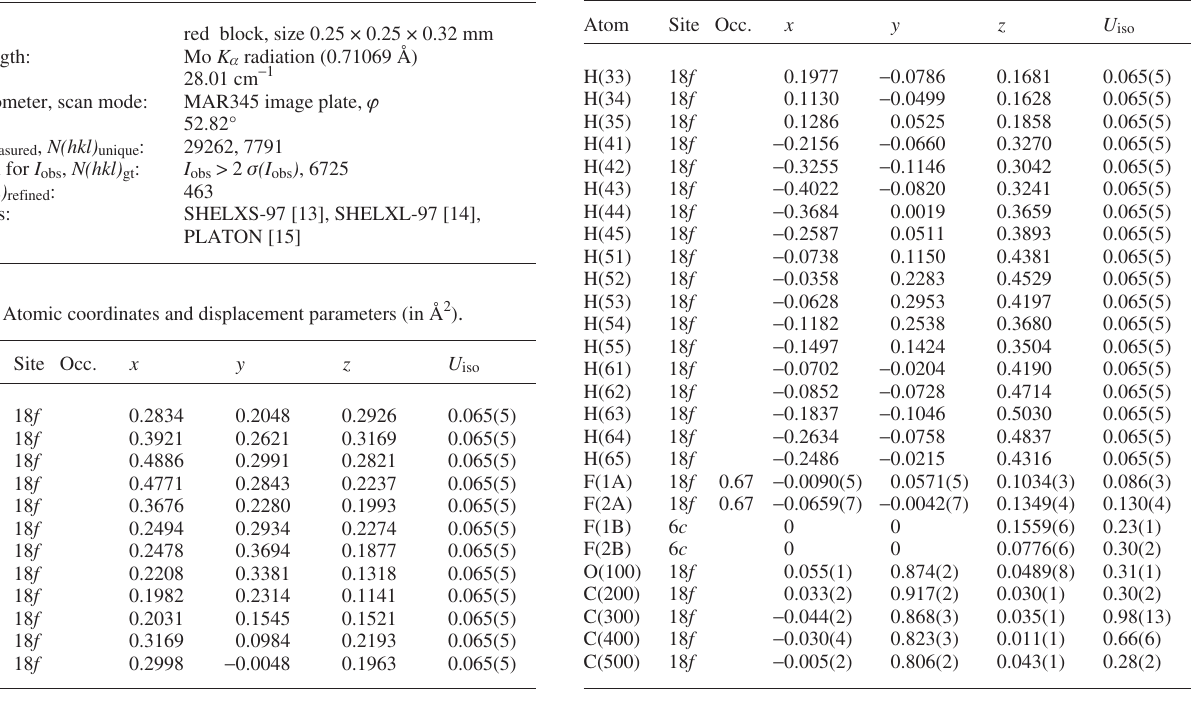
Table 3. Atomic coordinates and displacement parameters (in Å 2 ) .